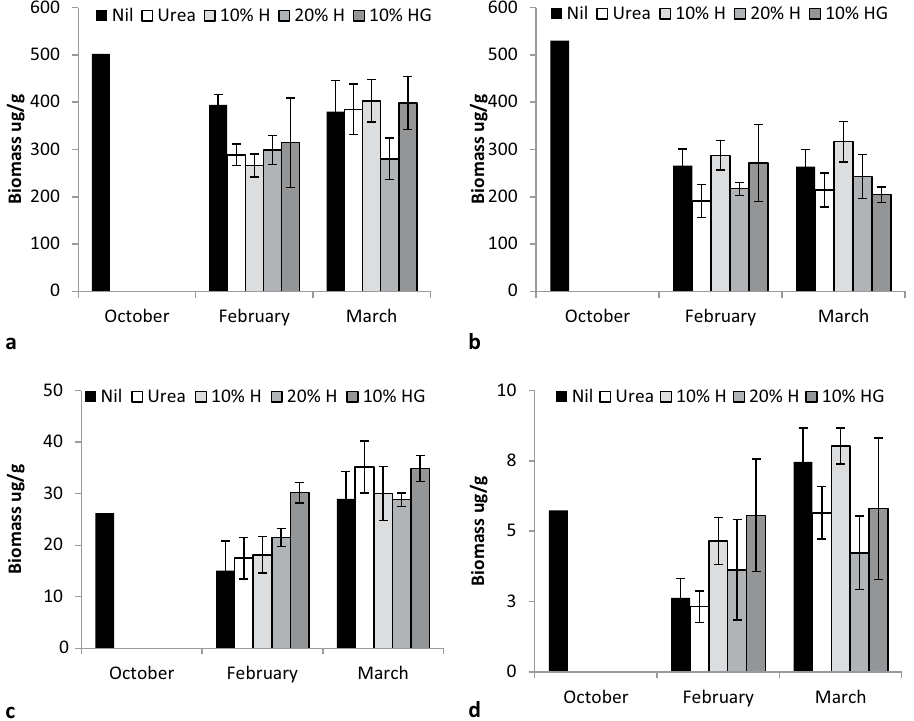
Figure 3. Effect of urea, humate (H) and guano (G) addition to urea on ( a ) total bacterial biomass and; ( b ) total fungal biomass ( c ) active bacterial biomass and ( d ) active fungal biomass, October 2014 to March 2015, mean ± standard